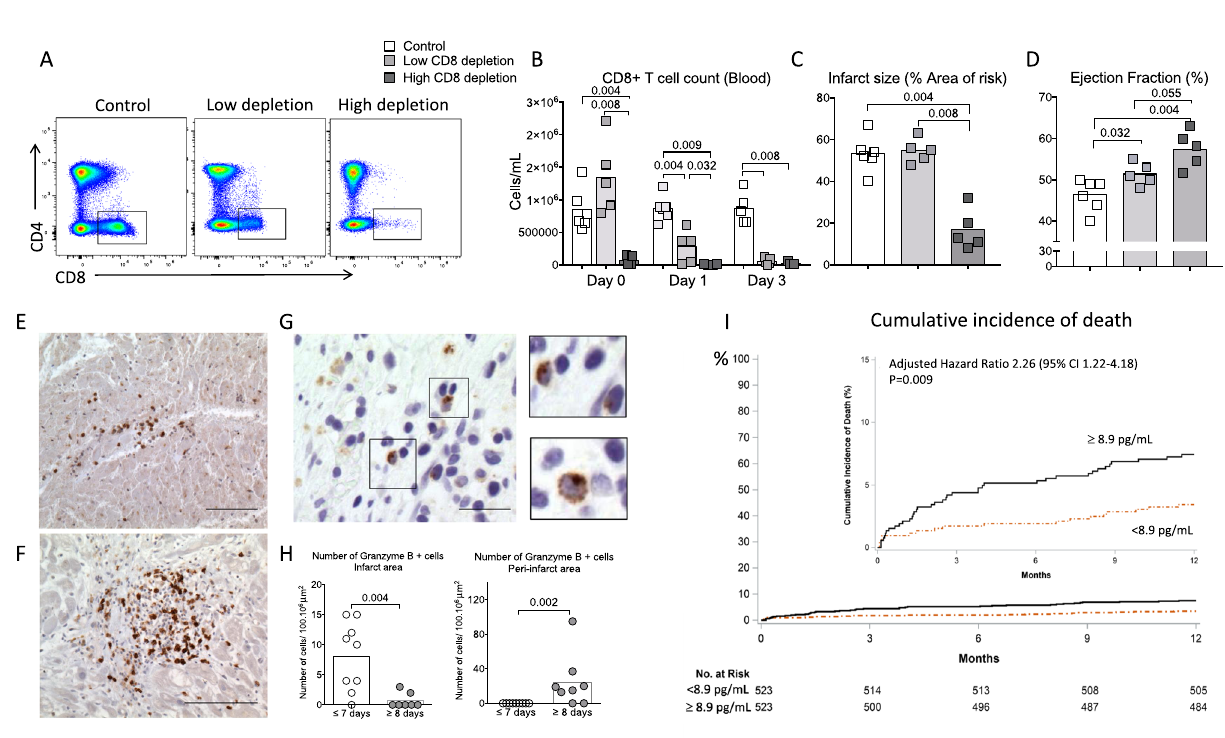
Fig. 6 Pathogenic role of CD8 + T cells in a model of myocardial ischemia/reperfusion in pig and relevance to the human disease. A Flow cytometry analysis of blood CD4 + T and CD8 + T subsets at day 1 after MI in control (PBS, CTR, n = 6), low (light gray, n = 5), and high (dark gray, n = 5) CD8-depleted groups. B Quanti fi cation of CD8 + T cell count in the blood at baseline, day 0, day 1, and day 3 after MI . C Representative picture and quanti fi cation of infarct size at day 14 in control, low, and high CD8-depleted groups. D Quantitative evaluation of left ventricle ejection fraction (Simpson) of CTR or CD8-depleted pigs. E , F Detection of CD8 + T cells (brown) in human heart biopsy of MI patients, using immunohistochemistry at day 3 ( E , upper) and day 8 ( F , lower) after MI, scale bar 50 μ m. G Detection of GRANZYME B + cells (brown) in human heart biopsy of MI patients, using immunohistochemistry, scale bar 20 μ m. H Quanti fi cation of GRANZYME B + cells (brown) in human heart biopsy of MI patients, using immunohistochemistry at different time points ( n = 9 day ≤ 7, n = 8 day ≥ 8). I Survival according to baseline circulating GRANZYME B level (< or > median value) in patients with acute MI ( n = 1046). High level of GRANZYME B at the admission for acute MI were independently predictive of death after 1 year of follow-up after multiple adjustments (see Methods and Supplementary Table 3). HR = hazard ratio. P values were calculated using two-tailed Mann-Whitney test ( H ) or Kruskal - Wallis test ( B – D